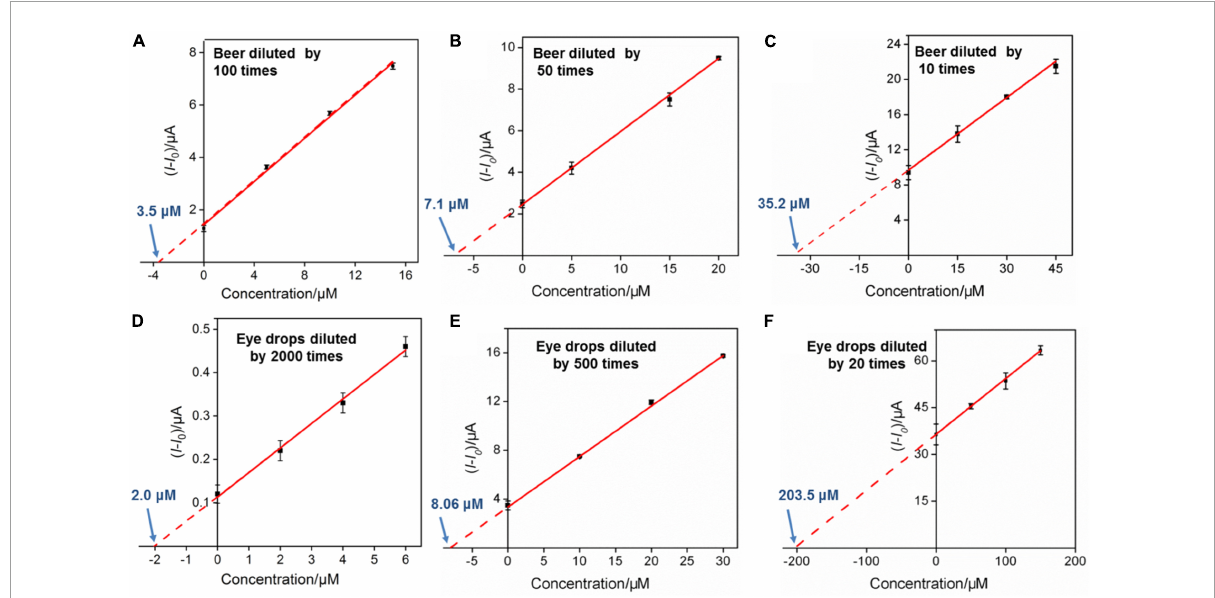
FIGURE7 (A–C) Linear relationship between the anodic peak current variation and G concentration in beer sample. The detected solution contains 1 µ M Ru(bpy) 32 + . (C,D) The linear relationship between the anodic peak current variation and ganciclovir concentration in ganciclovir eye drops sample. The detected solution contains 0.1 µ M Ru(bpy) 32 + (D) , 1.0 µ M Ru(bpy) 32 + (E) , and 10 µ M Ru(bpy) 32 + (F) , respectively.